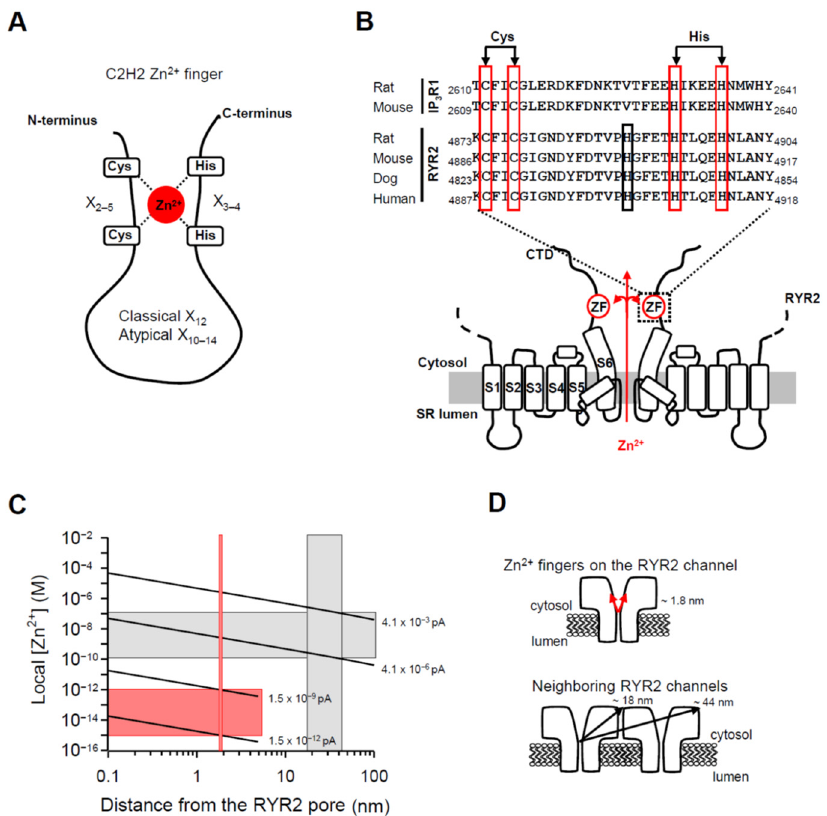
Figure 6. The RYR2 Zn 2+ finger might be locally controlled by the Zn 2+ current. ( A ) A schematic representation of the C2H2 Zn 2+ finger consisting of two Cysteines (Cys or C) and two Histidines (His or H), which are coordinated by Zn 2+ cation. Usually, 12 residues separate the last Cys and the first His residues (classical C2H2 pattern). In atypical C2H2 Zn 2+ fingers which still retain the ability to bind Zn 2+ , 10–14 residues are tolerated. ( B ) Sequence alignment of the Zn 2+ finger motifs identified within the C-terminal tail of the rat and mouse IP 3 R1 channels [81,82] and the RYR2 channel [55] from indicated mammals. The sequences were taken from the UniProtKB database. The Cys and His residues of the Zn 2+ finger domains with uncommon spacing (16 residues separating the Cys-Cys pair from the His-His pair) are boxed in red. The conserved His in the RYR2 sequences located 11 residues from the Cys-Cys pair, but not in the IP 3 R1 sequence, is highlighted in black. The membrane topology model of two opposing RYR2 subunits with six transmembrane domains was generated from recent work on the near-atomic resolution structure of the RYR2 isoform [55]. The putative Zn 2+ -finger domains (ZF) within the C-terminal tails might be supplied with luminal Zn 2+ emanating from the RYR2 pore in the lumen-to-cytosol direction when the channel is open. ( C ) The theoretical prediction of local Zn 2+ in respect to a distance from the Zn 2+ exit site (the open RYR2 pore). Zn 2+ accumulation profile was calculated with buffer present (1 mM EGTA). The red vertical bar indicates the Zn 2+ finger distance from a Zn 2+ point source (~1.8 nm). The gray vertical box indicates the center-to-corner distances covering the cytosolic domain of the neighboring RYR2 channel (~18–44 nm). At a distance of ~1.8 nm, the I 0,Zn of 1.5 × 10 − 12 –1.5 × 10 − 9 pA is required to elevate [Zn 2+ ] up to the femtomolar range (horizontal red bar), sufficient to saturate the Zn 2+ fingers. At a distance of ~18–44 nm, the I 0,Zn of 4.1 × 10 − 6 –4.1 × 10 − 3 pA is required to reach activating [Zn 2+ ] from 100 pM to 100 nM (horizontal gray bar). ( D ) Schematic depicting distances of the RYR2 Zn 2+ fingers and cytosolic domain of the neighboring RYR2 channel from the Zn 2+ exit site to help place the values on the X axis, shown in ( C ), in